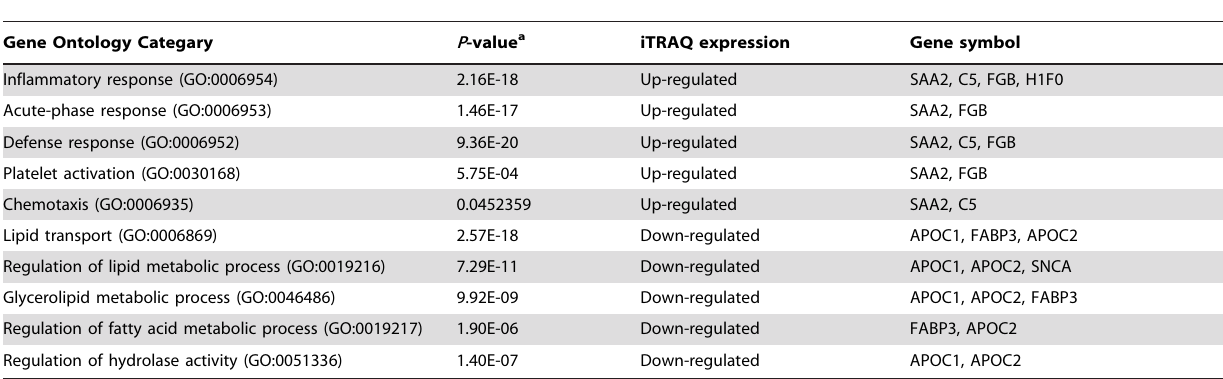
Table 3. Gene ontology (GO) category enrichments for the differentially expressed proteins in the HDL fractions.